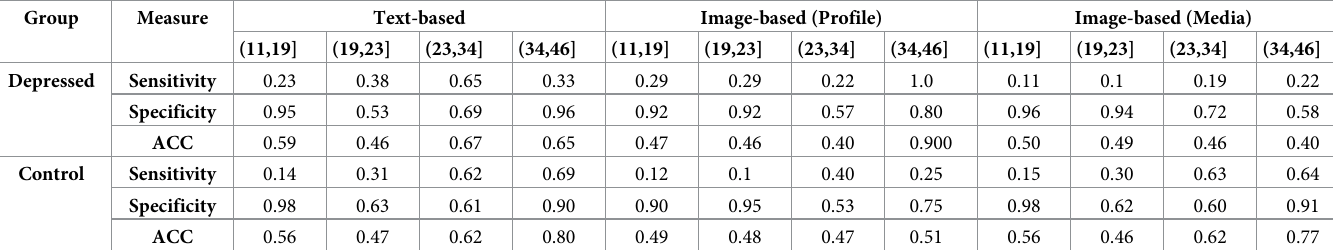
Table 6. Age Prediction performance from visual and textual content for different age group(years old).